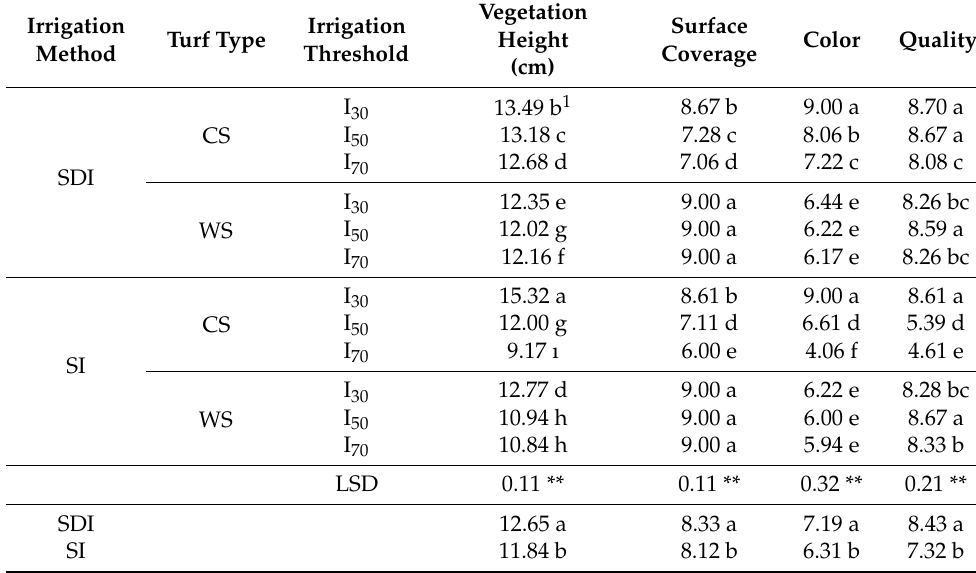
Table 3. Some growth and quality parameters of turf for all treatments in the year of